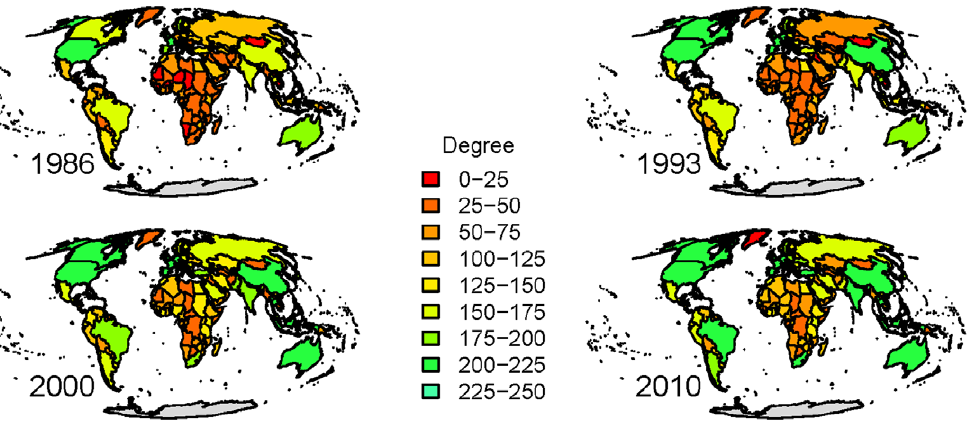
Figure 3. The degree (the sum of import and export connections) associated with each country for the years 1986, 1993, 2000, and 2010. While countries in general are more connected, this increase has not been as significant in most African countries.